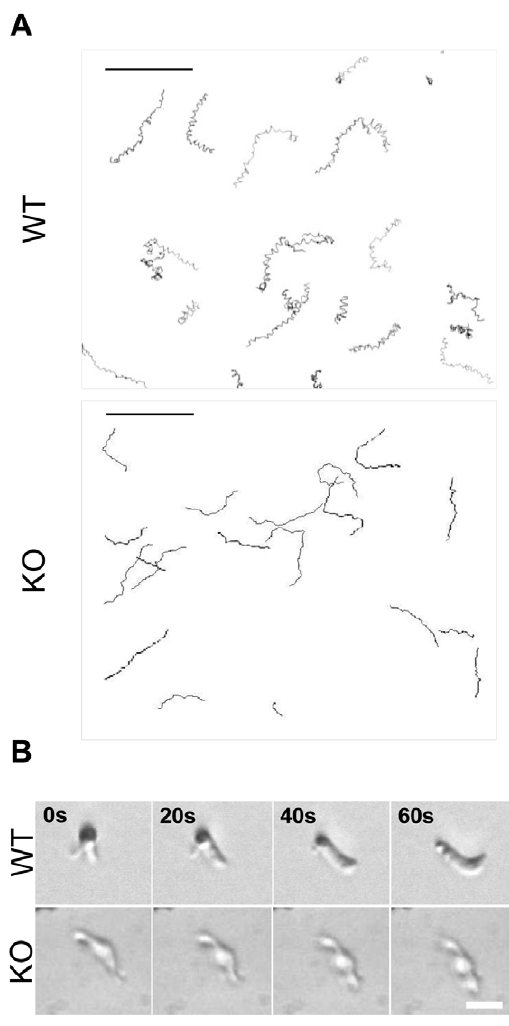
Figure 4. Reconstruction of WT and IMC1h-KO ookinete paths in Matrigel. A. Reconstruction of movement patterns from time-lapse movies of WT (upper panel) and IMC1h-KO ookinetes (lower panel) in Matrigel (20 minutes, one frame every 20 seconds). The reconstructions reveal the classical helical forward movements of gliding WT ookinetes. In contrast the IMC1h-KO ookinetes display a straight forward movement. Scale bar=50 m m. B. Details of ookinete motility showing drastic shape changes in moving IMC1h-KO ookinetes highlighting the loss of cell rigidity in the mutant. WT ookinetes also showed a 3D exploratory behaviour which was not observed in IMC1h-KO ookinetes. Scale bar=5 m m.